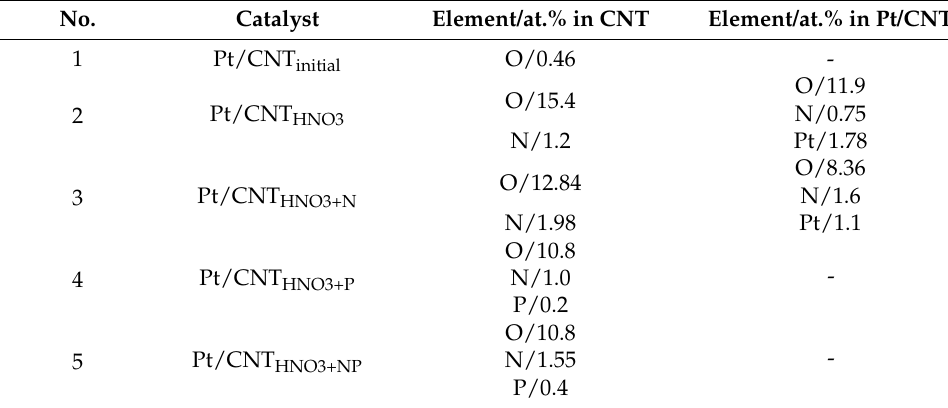
Table 2. XPS measurements of the studied